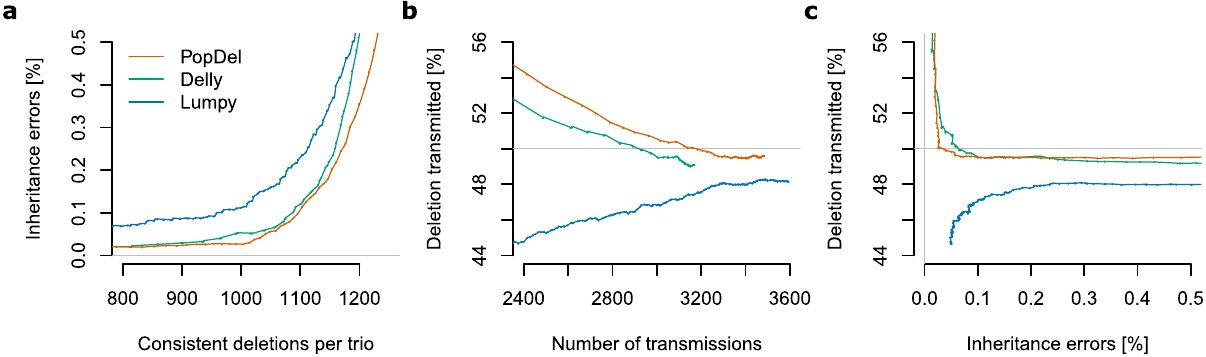
Fig. 5 Assessment of genotype inheritance patterns in the Polaris Kids cohort. We fi ltered call sets for Hardy-Weinberg equilibrium ( P value 0.01) and varying genotype quality thresholds. a Mendelian inheritance error rate by the number of deletion sites per trio that are consistent with Mendelian inheritance. b Percentage of transmitted deletion alleles for all deletions unique to one trio and one parent by the number of possible transmissions, that is, the number of deletions unique to one trio and one parent. c Percentage of transmitted deletion alleles by Mendelian inheritance error rate. Gray lines indicate the ideal values of the Mendelian inheritance error rate and transmission rate.